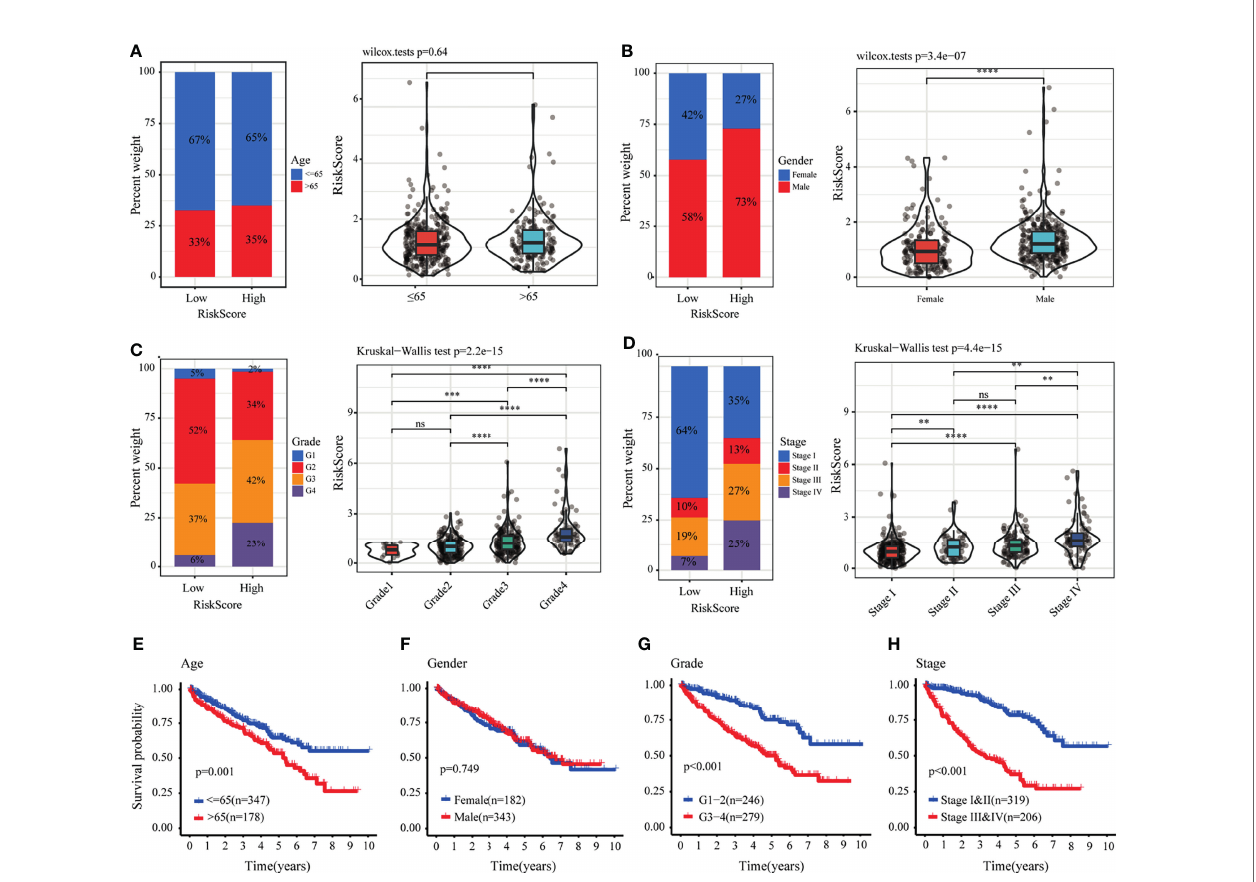
FIGURE 5 | Correlation between the lactate-related prognostic signature (LRPS) and clinical features in The Cancer Genome Atlas (TCGA) cohort. (A – D) Proportion of clinical features (age, gender, tumor grade, and stage) in the low- or high-risk group. Distribution of risk scores in different groups according to clinical features. (E – H) Kaplan – Meier analysis for patients with kidney renal clear cell carcinoma (KIRC) based on the LRPS strati fi ed by clinical features (age, gender, tumor grade, and stage). ** p < 0.01, *** p < 0.001, **** p < 0.0001. ns , not signi fi